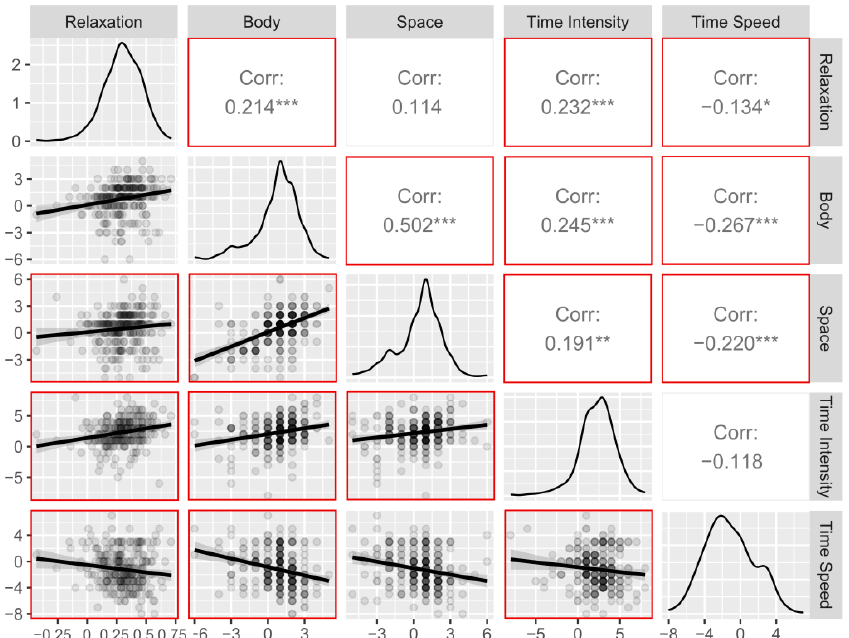
Figure 7. Relationship between post-training indices: scatterplots, distributions, and Pearson’s correlations. Significant correlations are framed by the red square. Body = Body Awareness, Space = Space Awareness. *** = p < 0.001, * = p < 0.05.